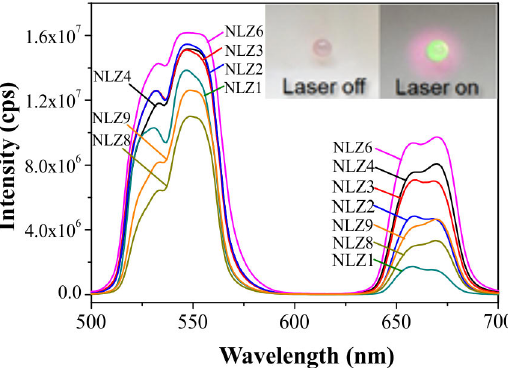
Fig. 3 Upconversion emission spectra of NLZ m ( m = 1, 2, 3, 4, 6, 8, 9) glass samples at the excitation of 1.5 W 980 nm laser. Insert is the digital image of the NLZ6 sample under excitation of 0.25 mW 808 nm